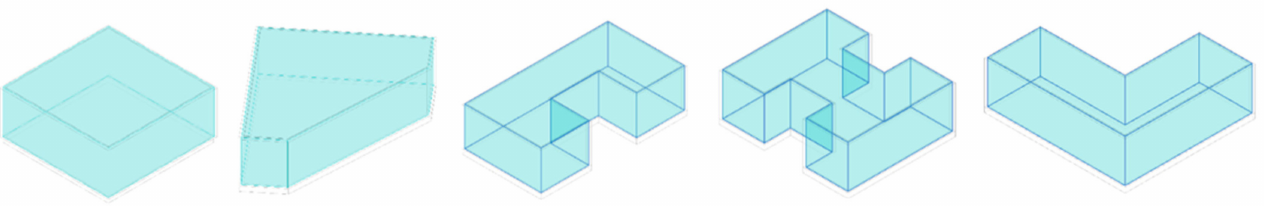
Figure 4. Revit analytical energy model.